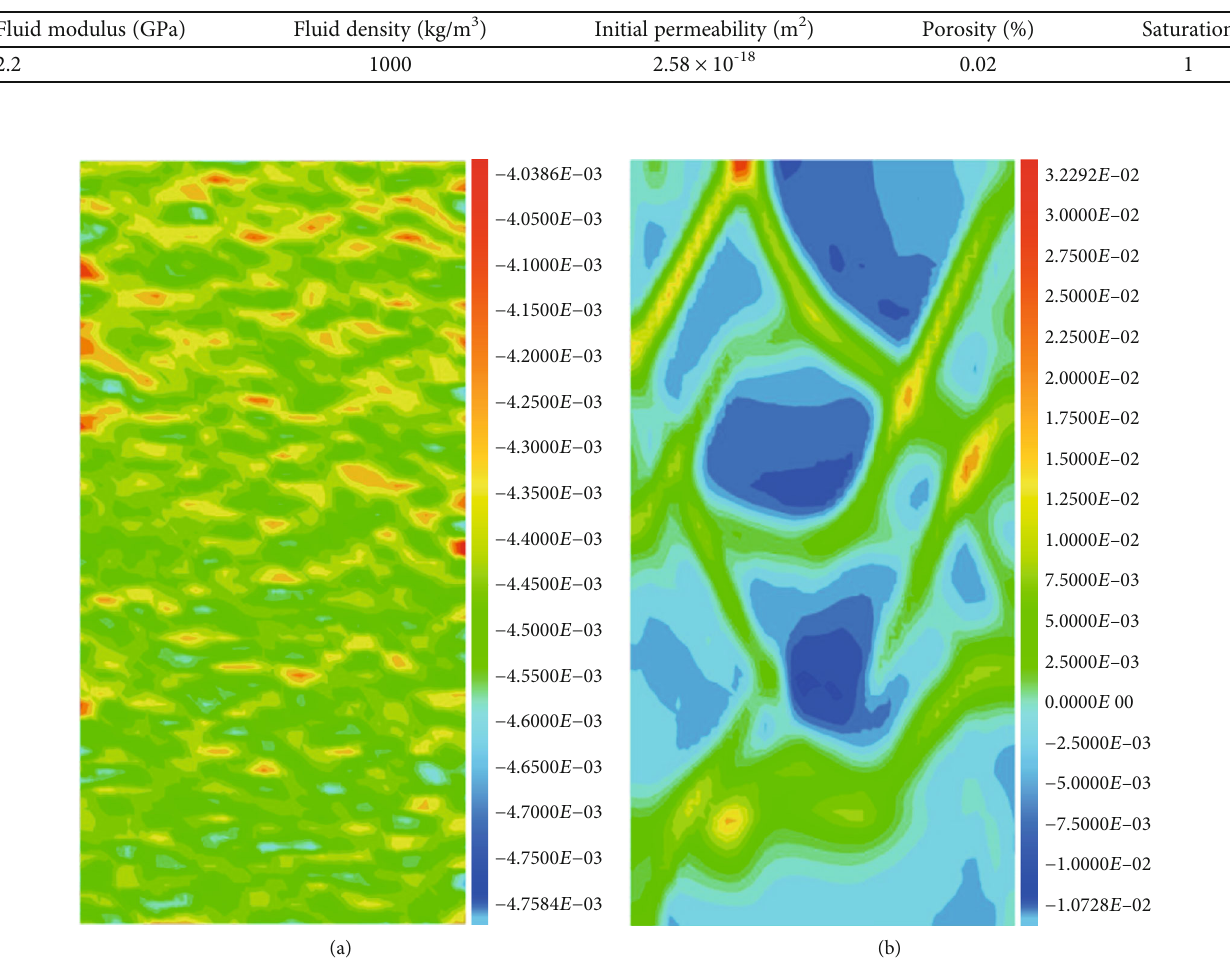
Figure 8: Volumetric strain for con fi ning pressure of 20 MPa: (a) compressed stage and (b) damaged